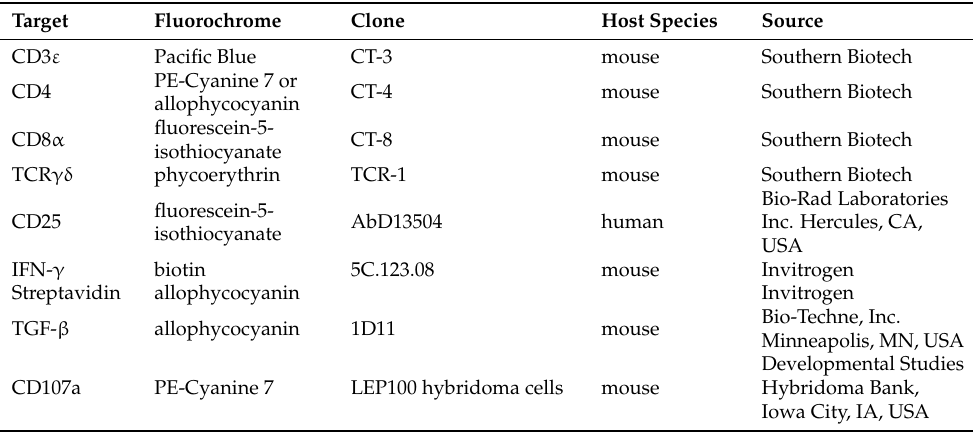
Table 1. List of antibodies for flow